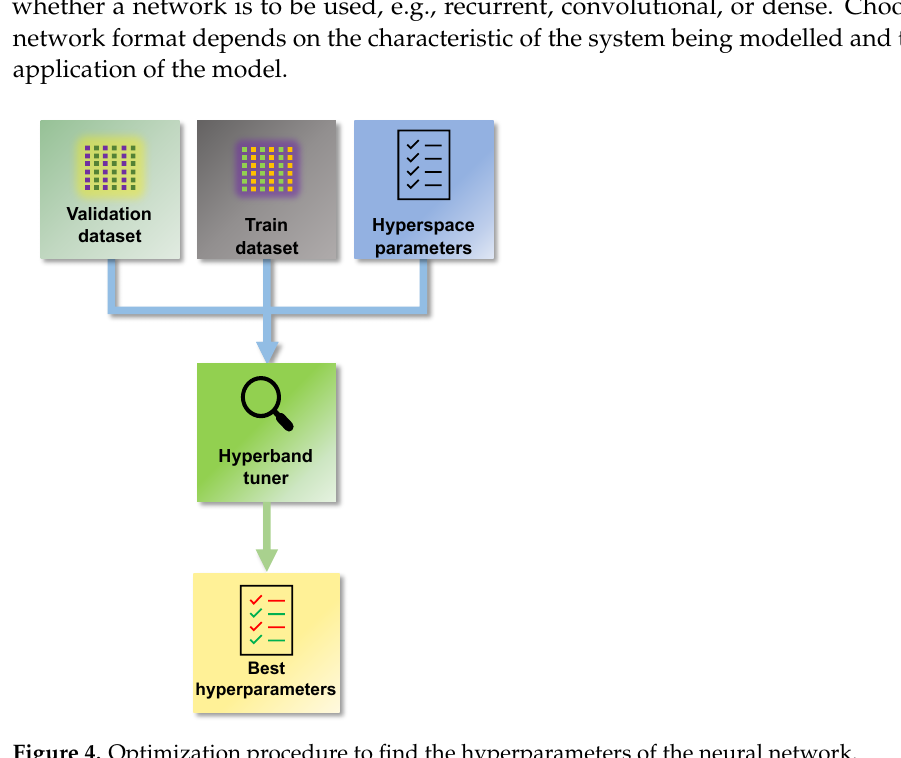
Figure 4. Optimization procedure to find the hyperparameters of the neural